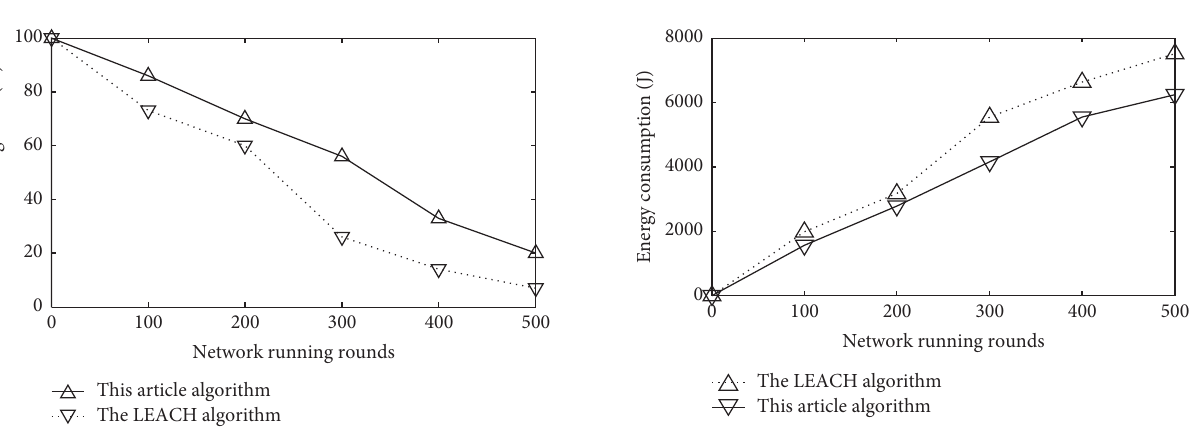
Figure 3: Network coverage rate comparison in this article’s al- gorithm and the LEACH algorithm under different network running rounds.